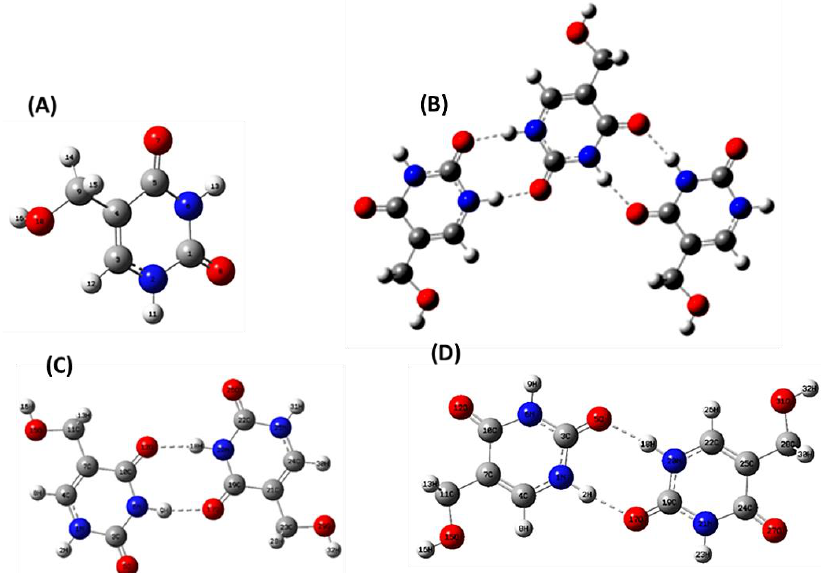
Figure 1. ( A ) The optimized molecular structure of 5-HMU, ( B ) its trimer, ( C ) dimer 1, ( D ) dimer 2.